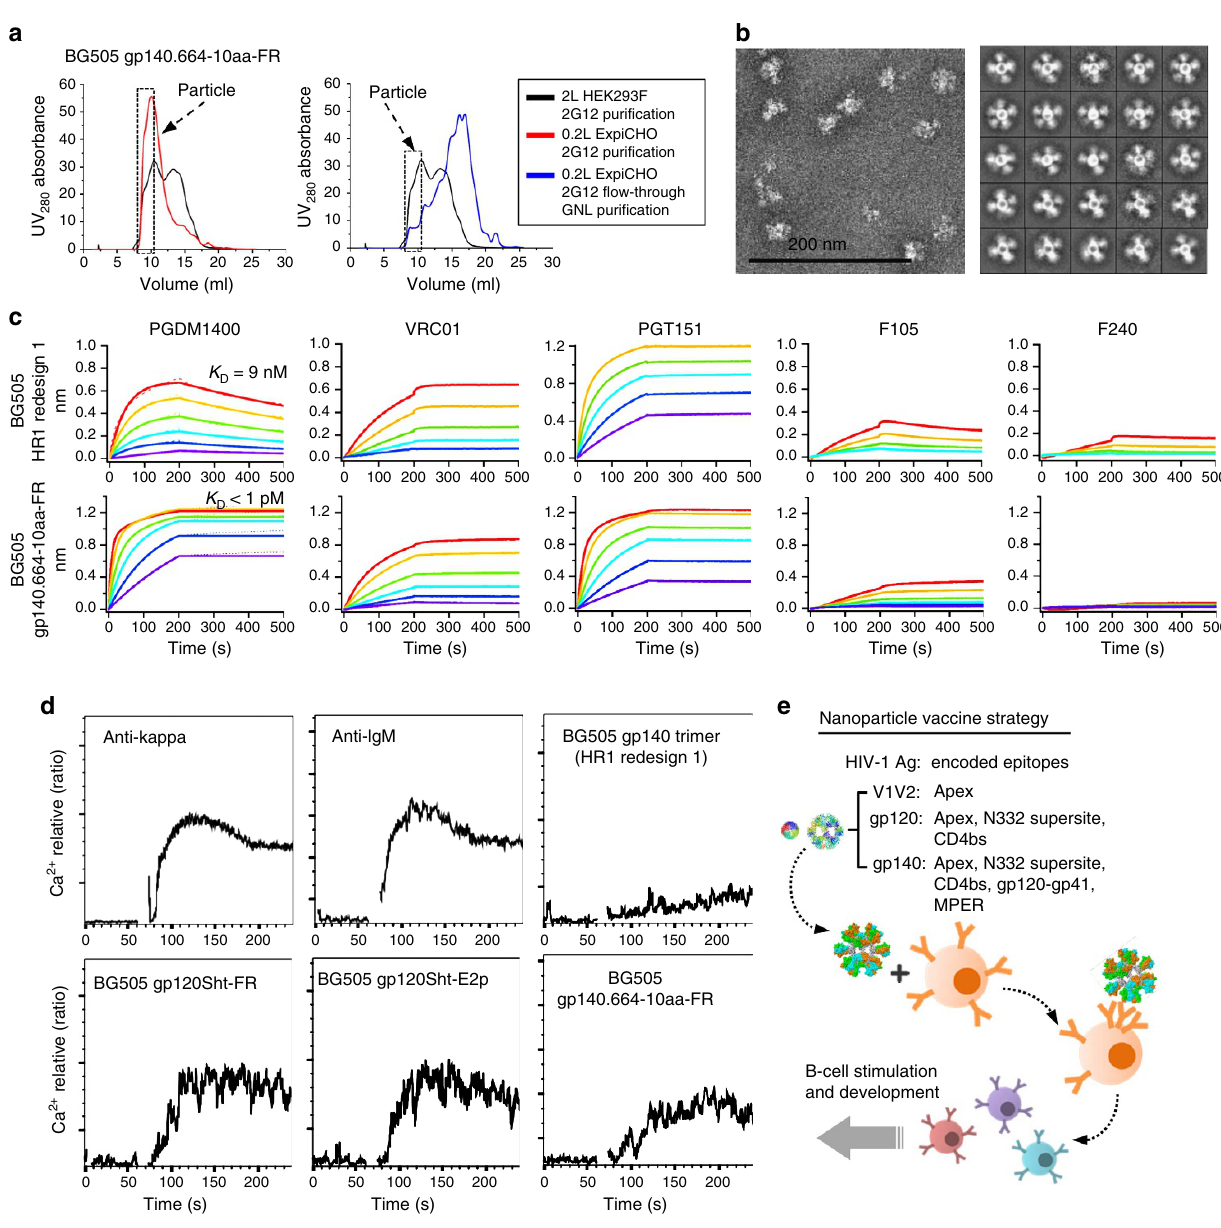
Figure 7 | High-yield nanoparticle expression and effective B-cell stimulation. ( a ) SEC profiles of 200-ml ExpiCHO-produced gp140.664-10aa-FR following 2G12 purification (red line, left) and 2G12 flow-through after additional GNL purification (blue line, right). The SEC profile of 2-liter HEK293F-produced gp140.664-10aa-FR after 2G12 purification (black line) is included for comparison. All SEC profiles were obtained from a Superose 6 10/ 300 GL column. Fractions used for EM and antigenic analyses (8.0–10.75ml) are indicated with a dashed box. ( b ) Micrograph (left) and 2D class averages (right) of ExpiCHO-produced gp140.664-10aa-FR derived from negative-stain EM. ( c ) Octet binding of HR1-redesigned gp140 trimer and ExpiCHO-produced gp140.664-10aa-FR to three bNAbs and two non-NAbs. Sensorgrams were obtained from an Octet RED96 instrument using a titration series of six starting at a maximum of 16nM for gp140.664-E2p. K D values are calculated from 1:1 global fitting for the apex-directed bNAb PGDM1400. ( d ) Ca 2 þ mobilization in B-cell transfectants carrying VRC01 BCR. WEHI231 cells expressing a doxycyclin-inducible form of VRC01 BCR were stimulated with anti-BCR antibodies or the indicated antigens at a concentration of 10 m gml (cid:2) 1 : anti-human Ig k -chain F(ab’) 2 ; anti-mouse IgM; HR1-redesigned gp140 trimer, gp120Sht-FR, gp120Sht- E2p or gp140.664-10aa-FR. ( e ) Schematic view of the nanoparticle vaccine strategy. Structures of FR and E2p nanoparticles are shown with three trimeric antigens and their encoded bNAb epitopes. Nanoparticle-induced BCR clustering and B-cell lineage maturation leading to bNAbs are depicted